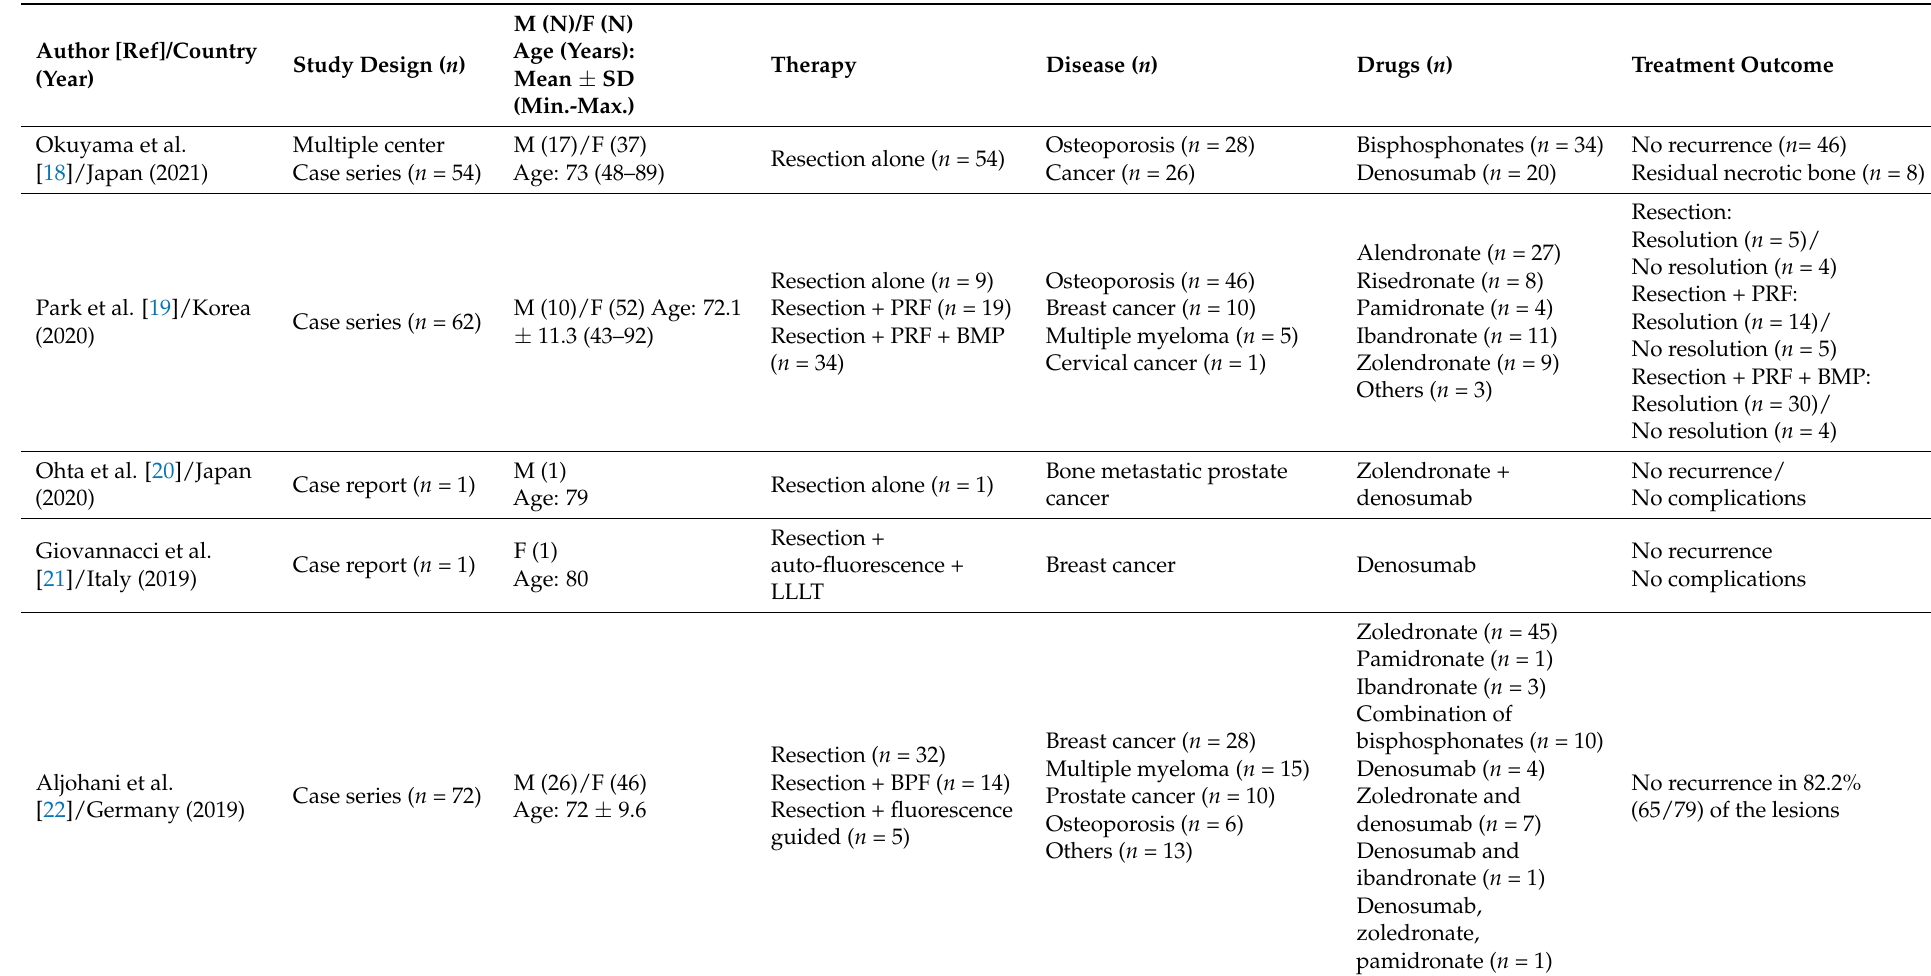
Table 2. Surgical treatment of patients with maxillary MRONJ: a systematic review of case report and case